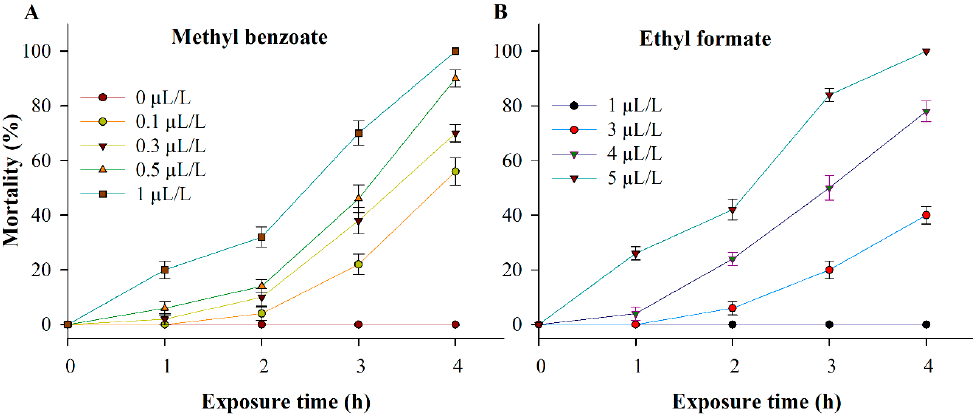
Figure 3. Fumigation toxicity of methyl benzoate (MBe) ( A ) and ethyl formate (positive control) ( B ) against adults of Plodia interpunctella. Adult mortality was evaluated at 1-h intervals during 4 h of exposure. The LT 50 values for MBe at 0.1, 0.3, 0.5, and 1 μ L/L air were 3.8 h ( χ 2 = 0.54, df = 2, p = 0.764), 3.3 h ( χ 2 = 7.31, df = 2, p = 0.026), 2.8 h ( χ 2 = 32.7, df = 2, p < 0.0001), and 2.0 h ( χ 2 =